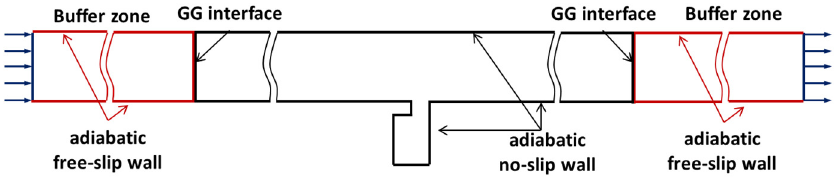
Figure 5. Computational domain.